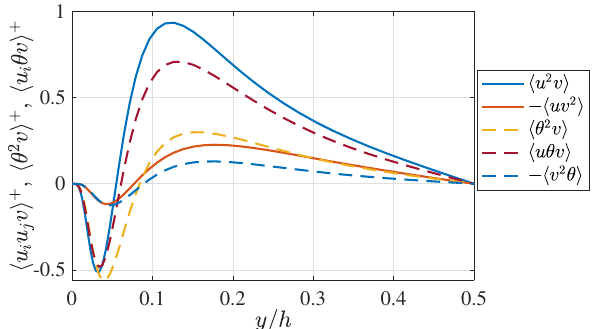
(cid:10) (cid:11) (cid:10) (cid:11) u 2 v uv 2 and − and the temperature-velocity